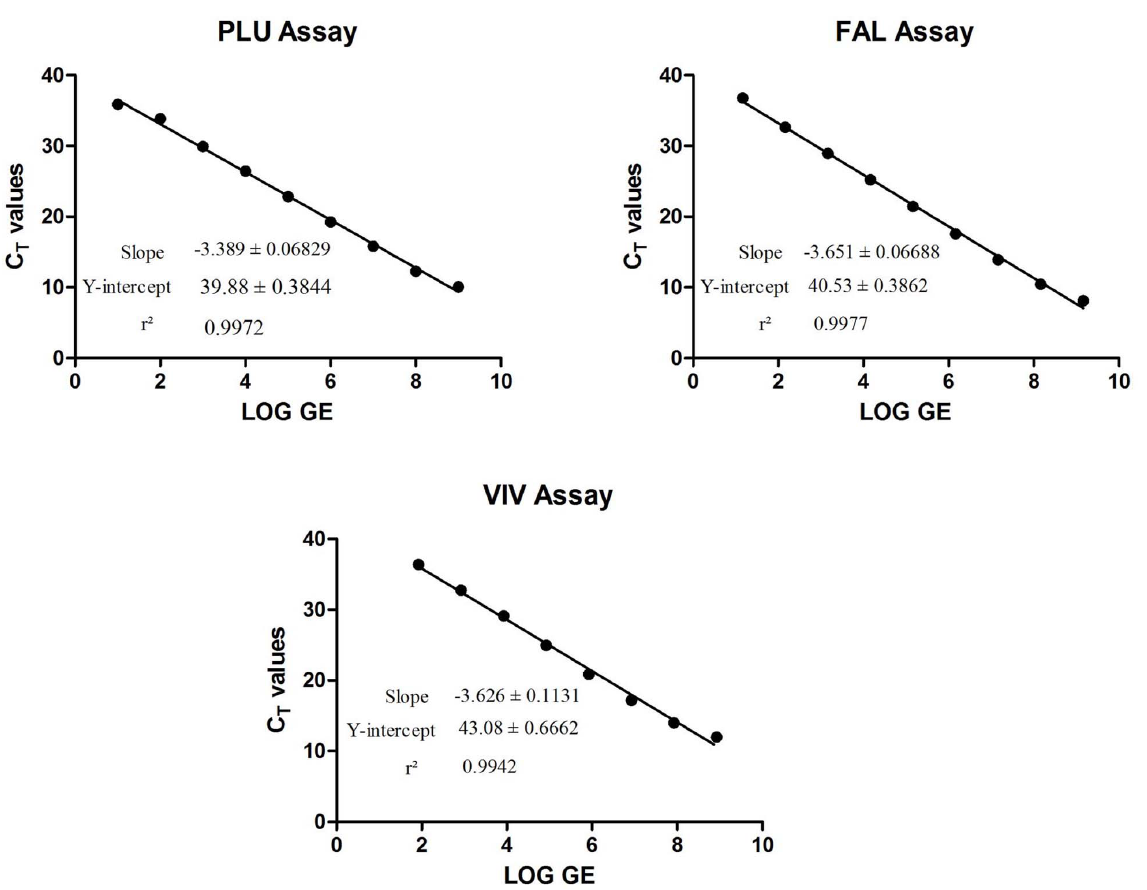
Figure 2. Linear regression plots for absolute qPCR assays. Real-time PCR assays were performed using plasmid DNAs for each assay. Plasmid DNA was 10-fold serially diluted at each point and ran in 4–8 replicates. A linear regression plot was generated using GraphPad Prism. The slope, the Y-intercept and the r 2 value were determined. Data shown confirms that these assays perform with high efficiencies.